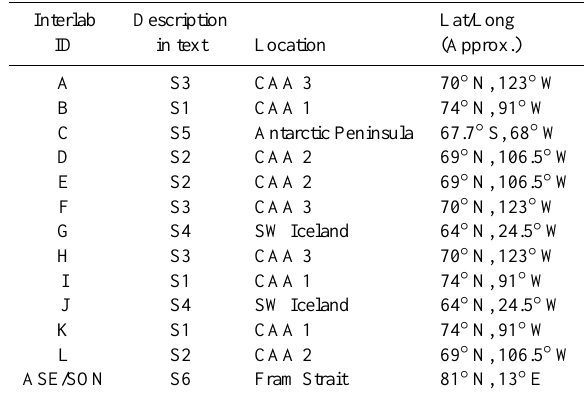
Table 1. Description of sediments analysed in the current